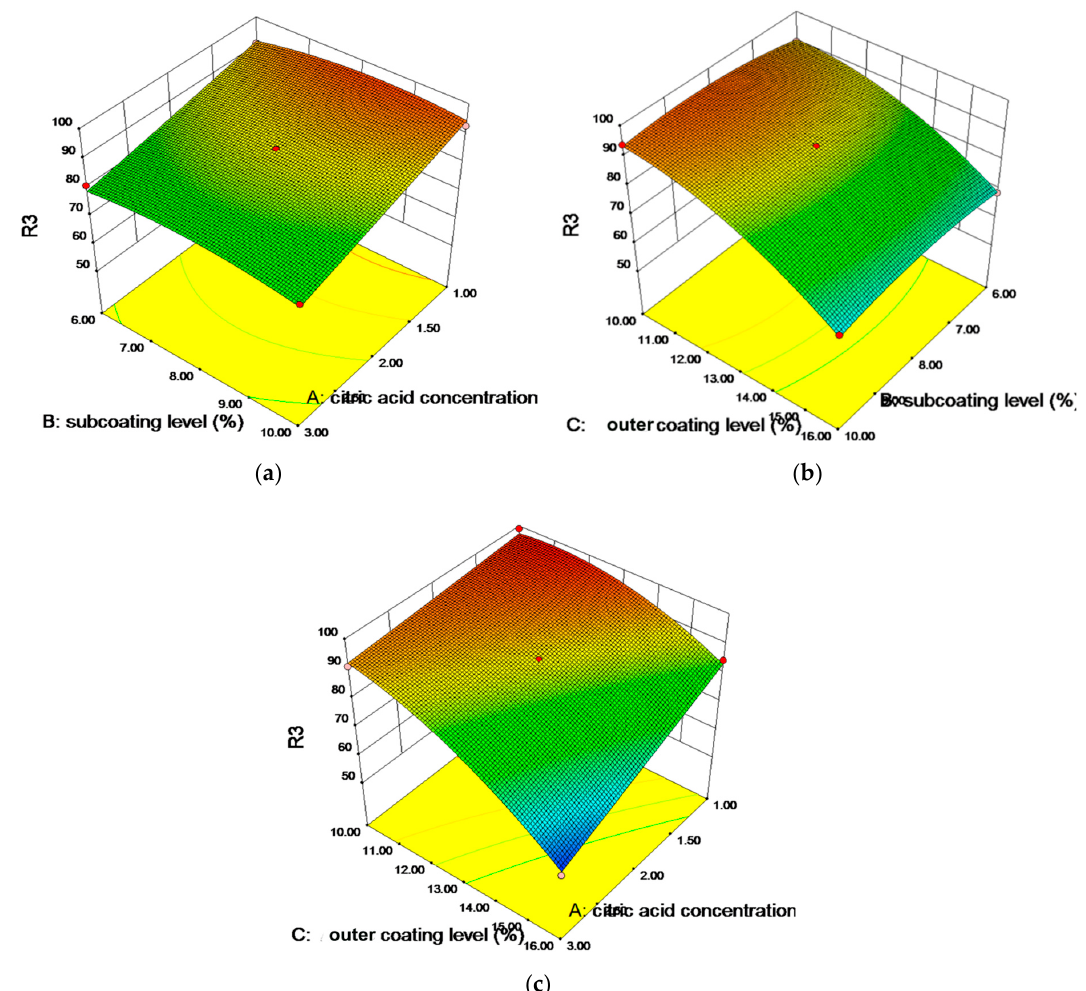
Figure 5. Contour plots showing the effects of ( a ) X 1 and X 2 , ( b ) X 2 and X 3 , and ( c ) X 1 and X 3 on the response Y 3 .